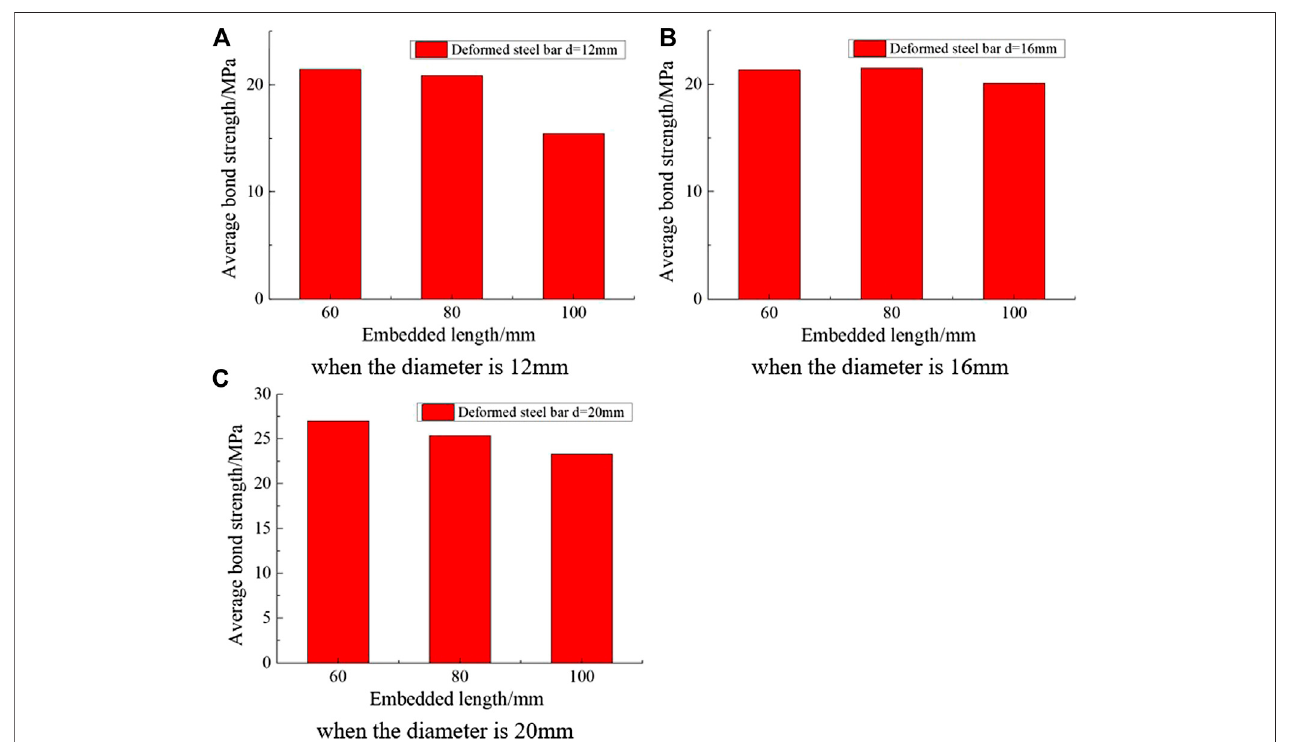
FIGURE 8 | The in fl uence of embedded length on bond